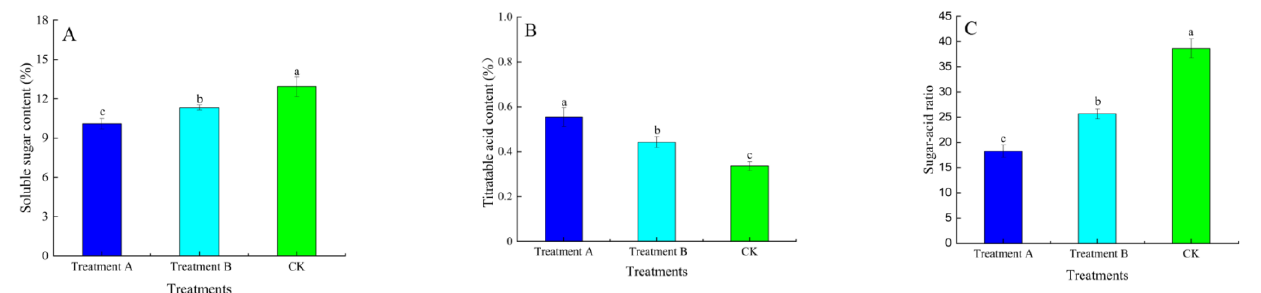
Figure 5. Effects of artificial ripening treatment on soluble sugar content, titratable acid content, and sugar–acid ratio. ( A ) Soluble sugar content; ( B ) titratable acid content; ( C ) sugar–acid ratio. In the graphs, different lowercase letters indicate significant differences between treatments ( p < 0.05).